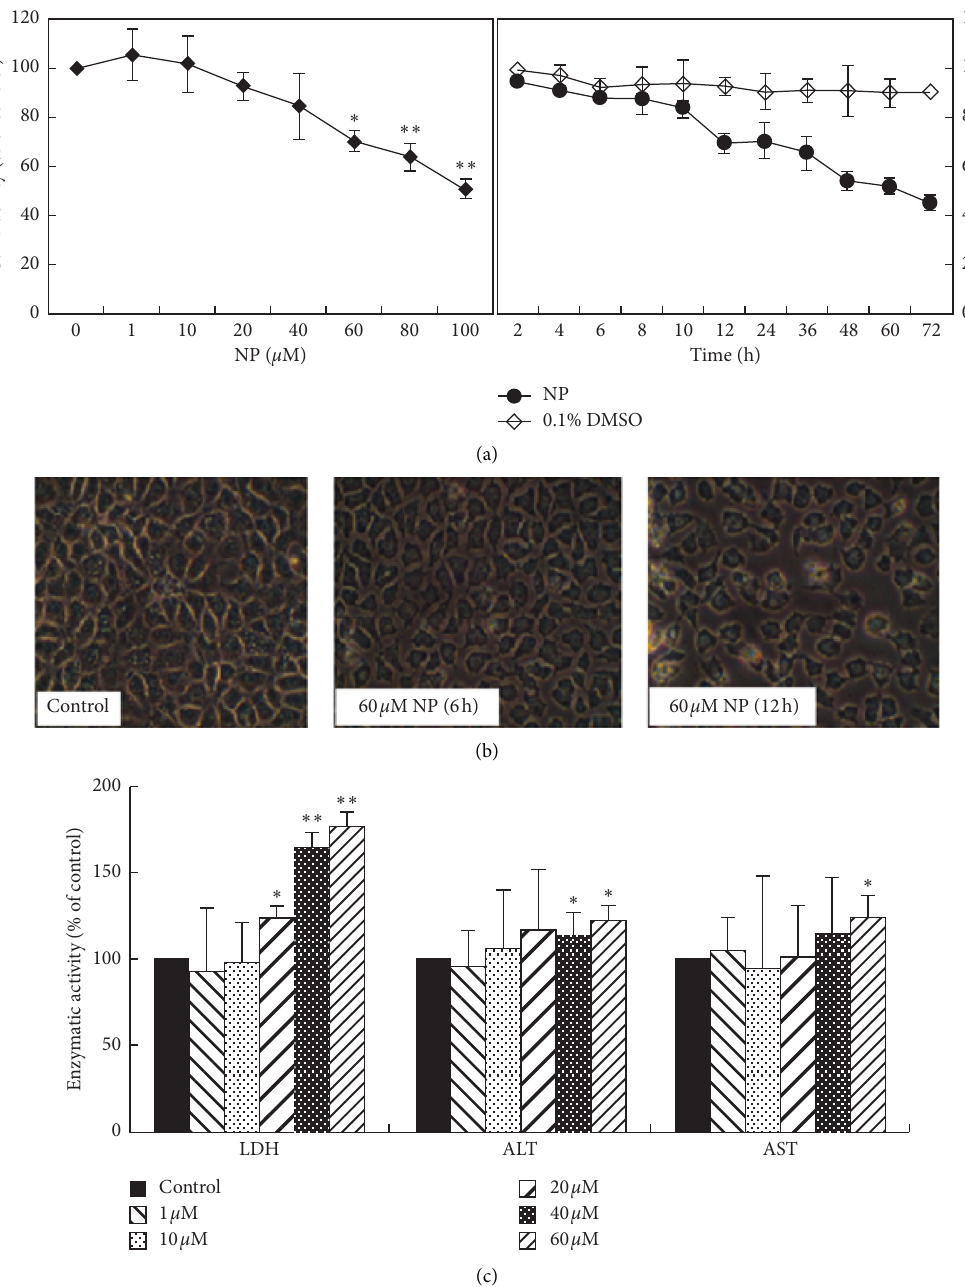
Figure 1: NP induced cytotoxicity to NCTC Clone 1469 cells. (a) Time- and dose-dependent cell viability. Cultured cells were exposed to different concentrations of NP (0, 1, 10, 20, 40, 60, and 100 μ M) for 12 h or 60 μ M NP for different time periods (2, 4, 6, 8, 10, 12, 24, 36, 48, 60, and 72 h). After the experiment, cell viability was examined by MTT assay. (b) Cell morphology was examined by microscopy with a photography system. (c) Effect of NP on LDH, ALT, and AST leakage in the supernatant. The activities of the LDH, AST, and ALT were expressed as % of control. Results are presented as mean ± SD with triplicate measurement. ∗ P < 0 . 05, ∗∗ P < 0 . 01 versus the control